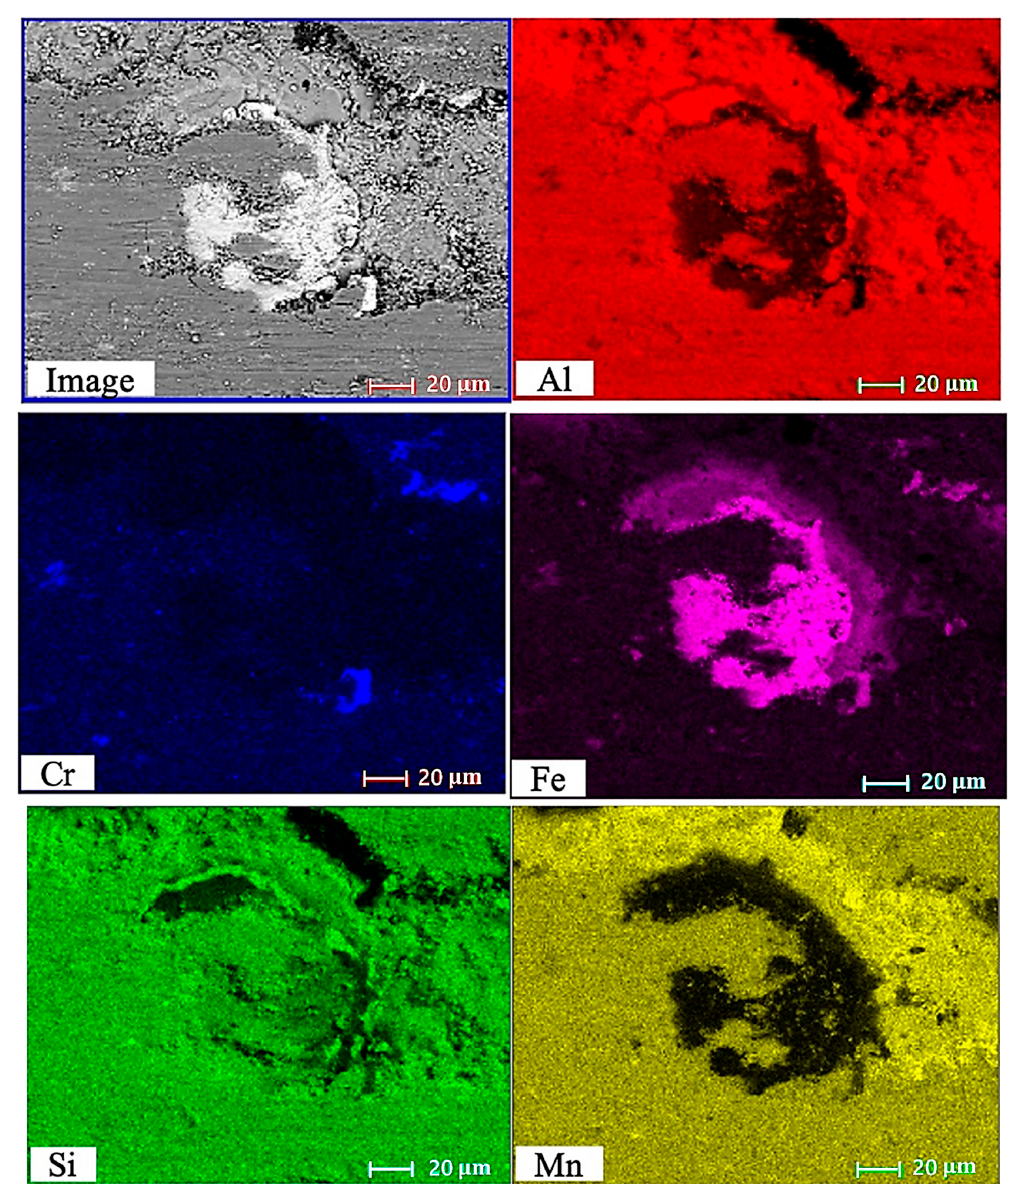
Figure 15. EDS corresponding elemental mapping and SEM image of the coating of sample processed at 850 °C and 20 MPa for 7200 s after pin-on-disk wear testing.